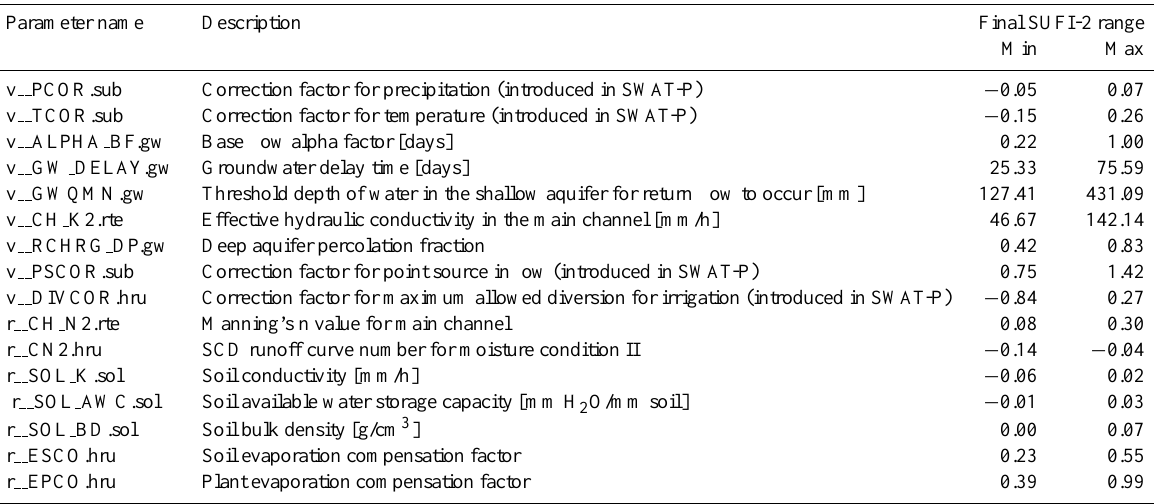
Table 1. Parameters sensitive to discharge calibrated using SUFI-2 (prefix v indicates that the parameter value is replaced by a given value; prefix r indicates the parameter value is multiplied by (1 + a given value) (Abbaspour et al., 2007).